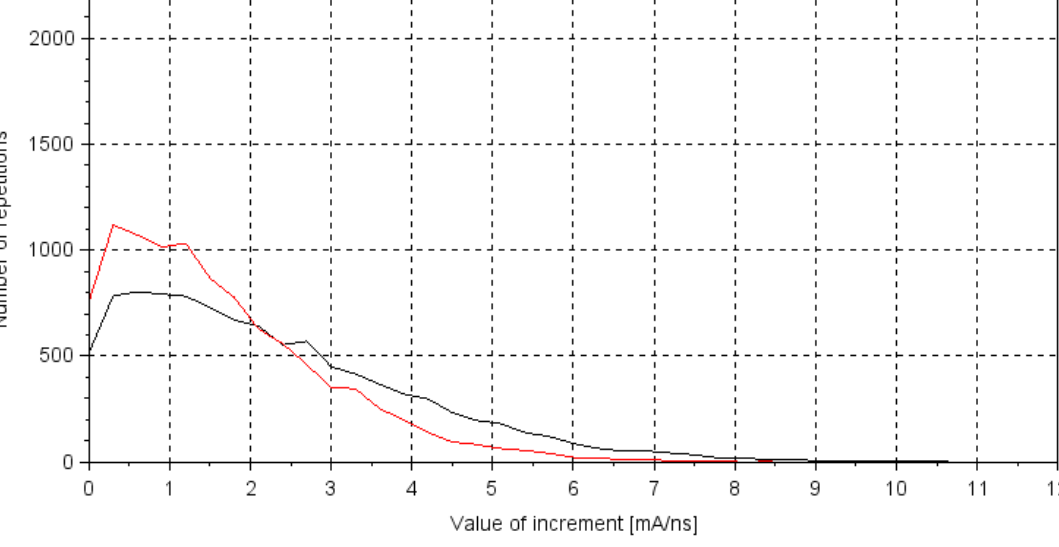
Figure 13. Figure showing 10 kpts decompositions of signals at different distances of electrodes, with 1 mm (black) and 1 cm (red) (conditions: voltage of 1.6 kV DC and current of 1 A DC at each measurement).